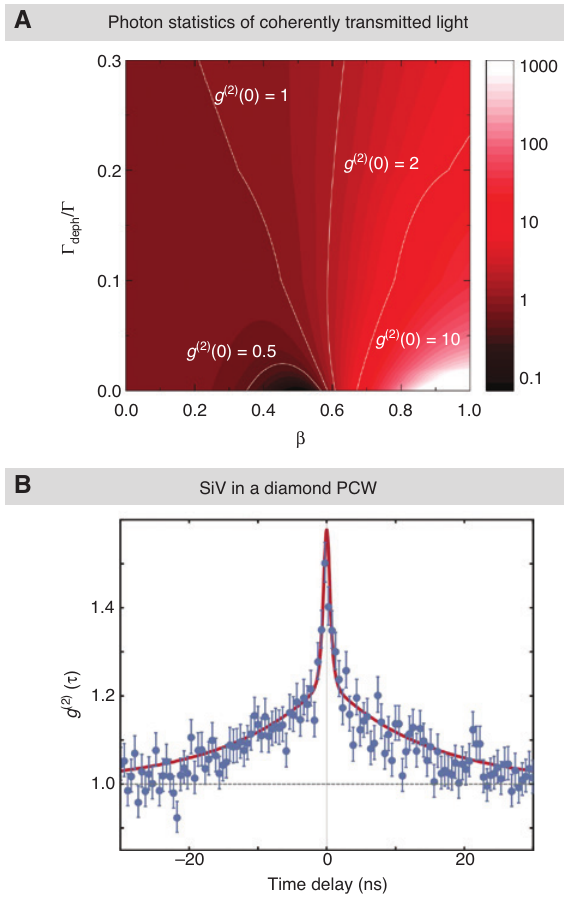
Figure 4: Two-photon correlations for a weak coherent-state scattering from a TLS embedded in a